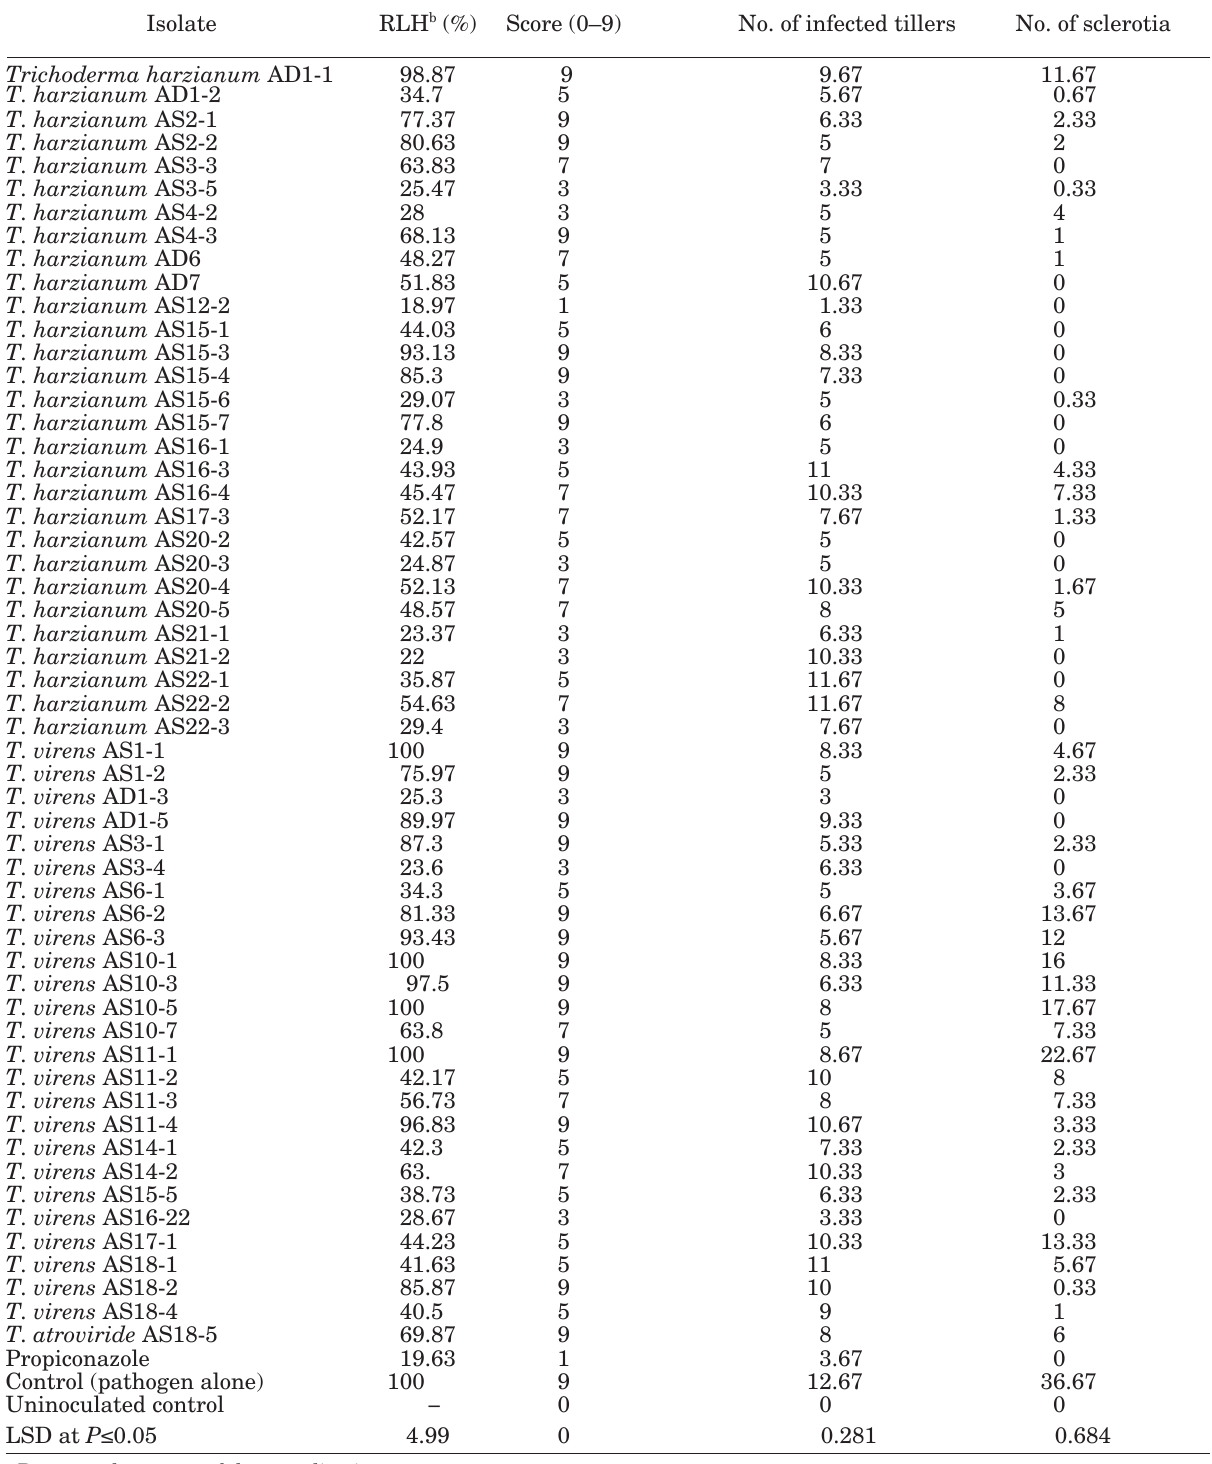
Table 4. Effect of selected Trichoderma isolates on the control of rice sheath blight in the greenhouse a . Isolate RLH b (%) Score